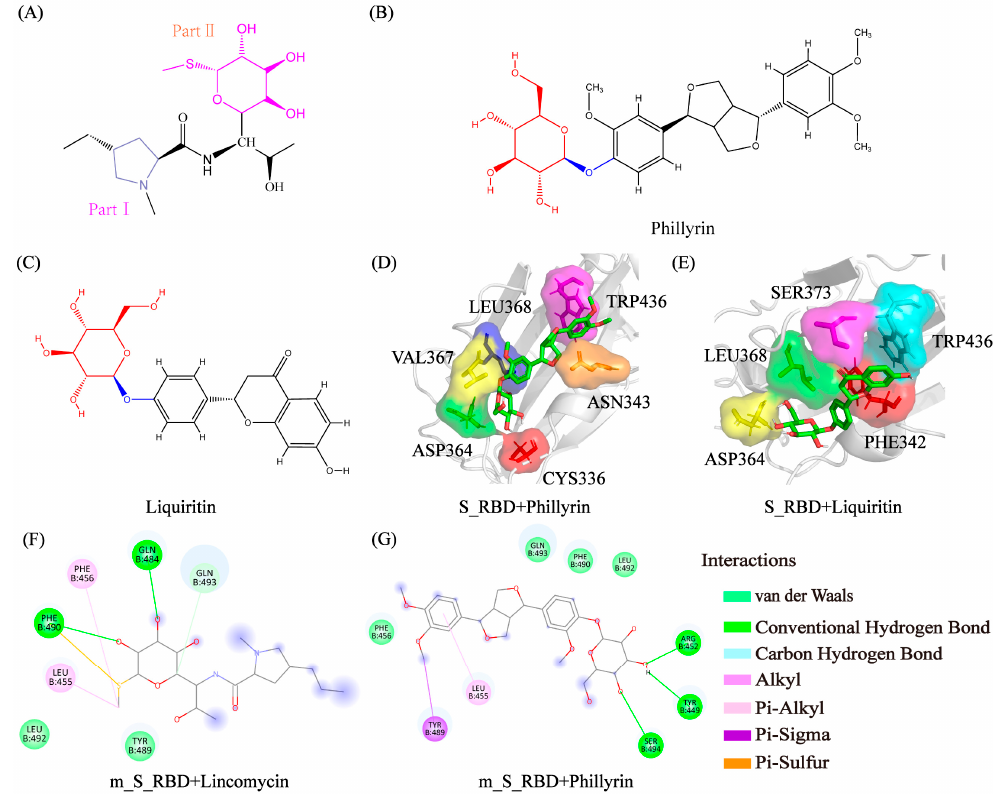
Figure 7. ( A ) The chemical structure of Lincomycin with the glycosyl group. Lincomycin is divided into two heterocycles parts: part I (dark blue) and part II (pink). The chemical structure of ( B ) Phillyrin and ( C ) Liquiritin. The parts of glycosyl group are marked as red. The binding model between the protein S_RBD and ( D ) Phillyrin and ( E ) Liquiritin in domain 1 using the Pymol method. The binding models of the inhibitors and the mutant S_RBD (m_S_RBD) in the genetic variants of SARS-CoV-2 ( F , G ). The inhibitors are shown as sticks using Discovery Studio. The types of interactions are the hydrophobic interactions (conventional hydrogen bond, alkyl interaction, pi-alkyl interaction and carbon hydrogen bond), ππ -sigma interaction and pi-sulfur interaction.